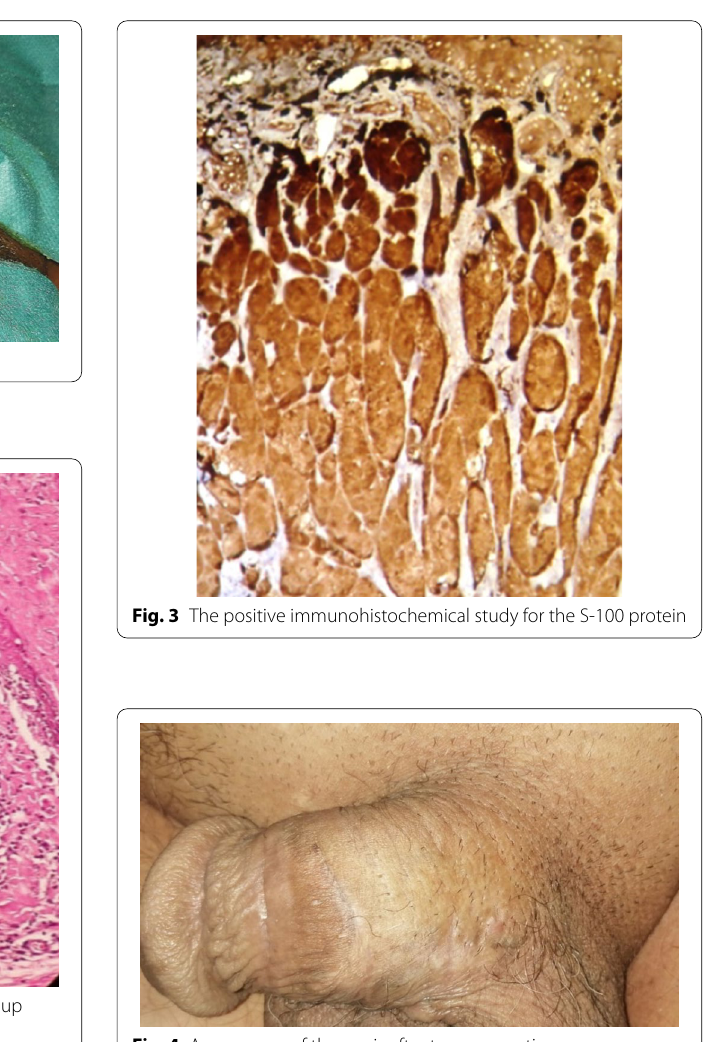
Fig. 4 Appearance of the penis after tumor